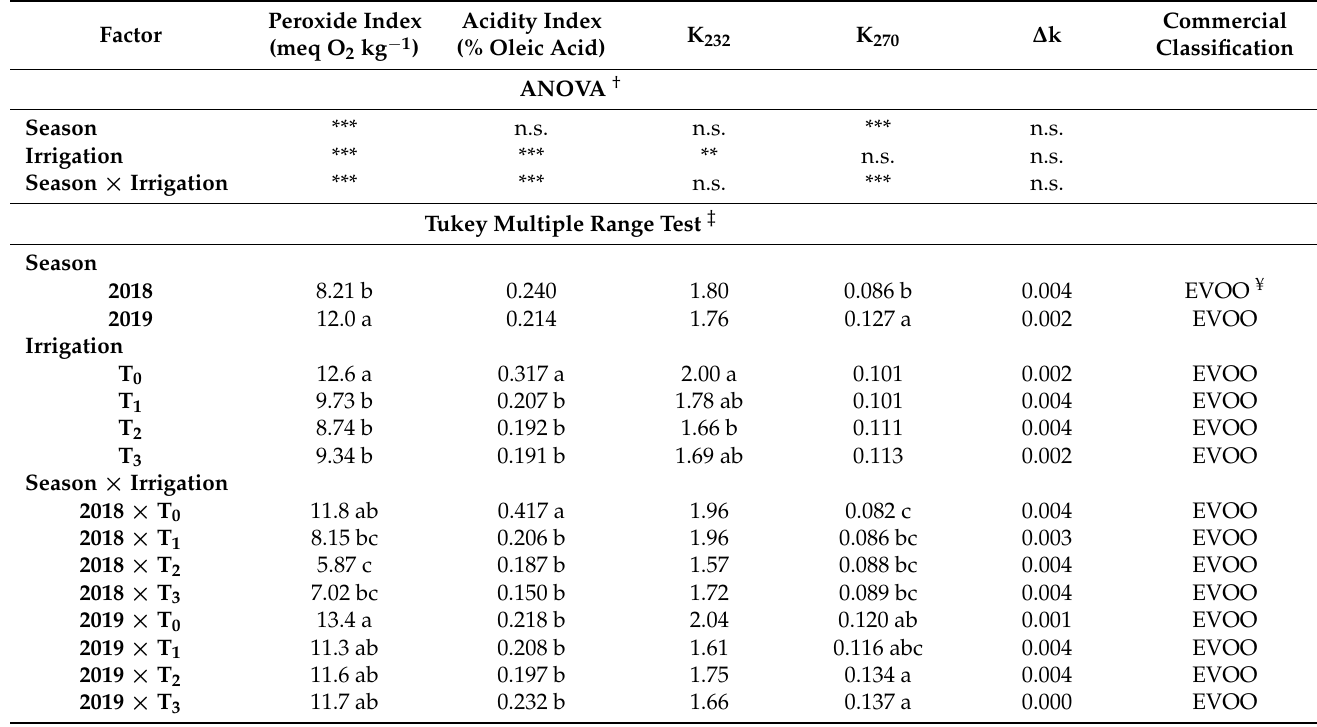
Table 2. Quality parameters of ‘Arbequina’ olive oil samples, obtained from a super-high-density olive tree orchard, according to the requirements of the International Olive Council